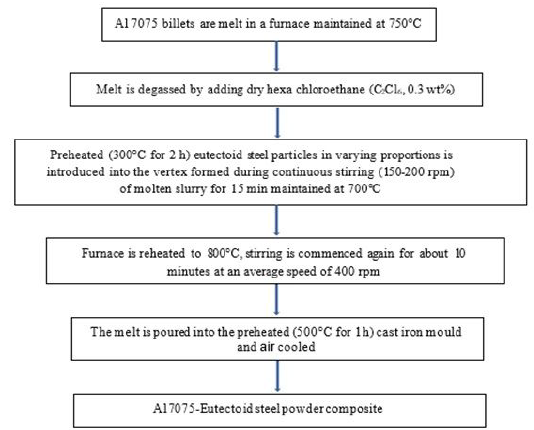
Figure 1. Flow chart of stir casting method used in the